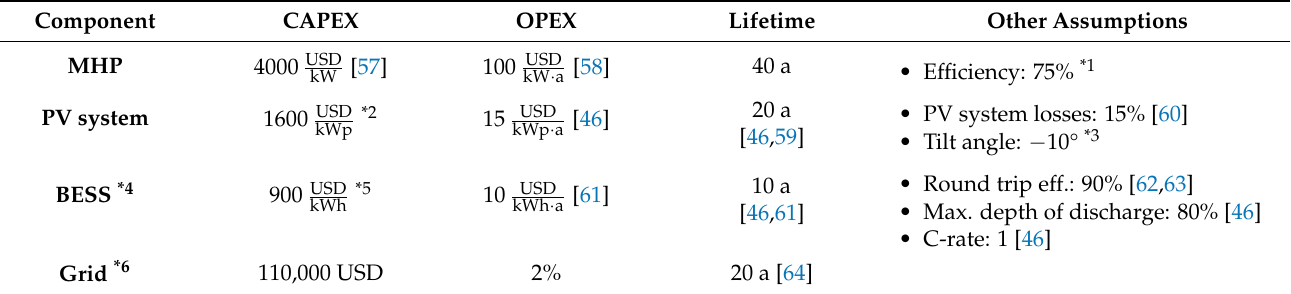
Table 6. Techno-economic assumptions for the system